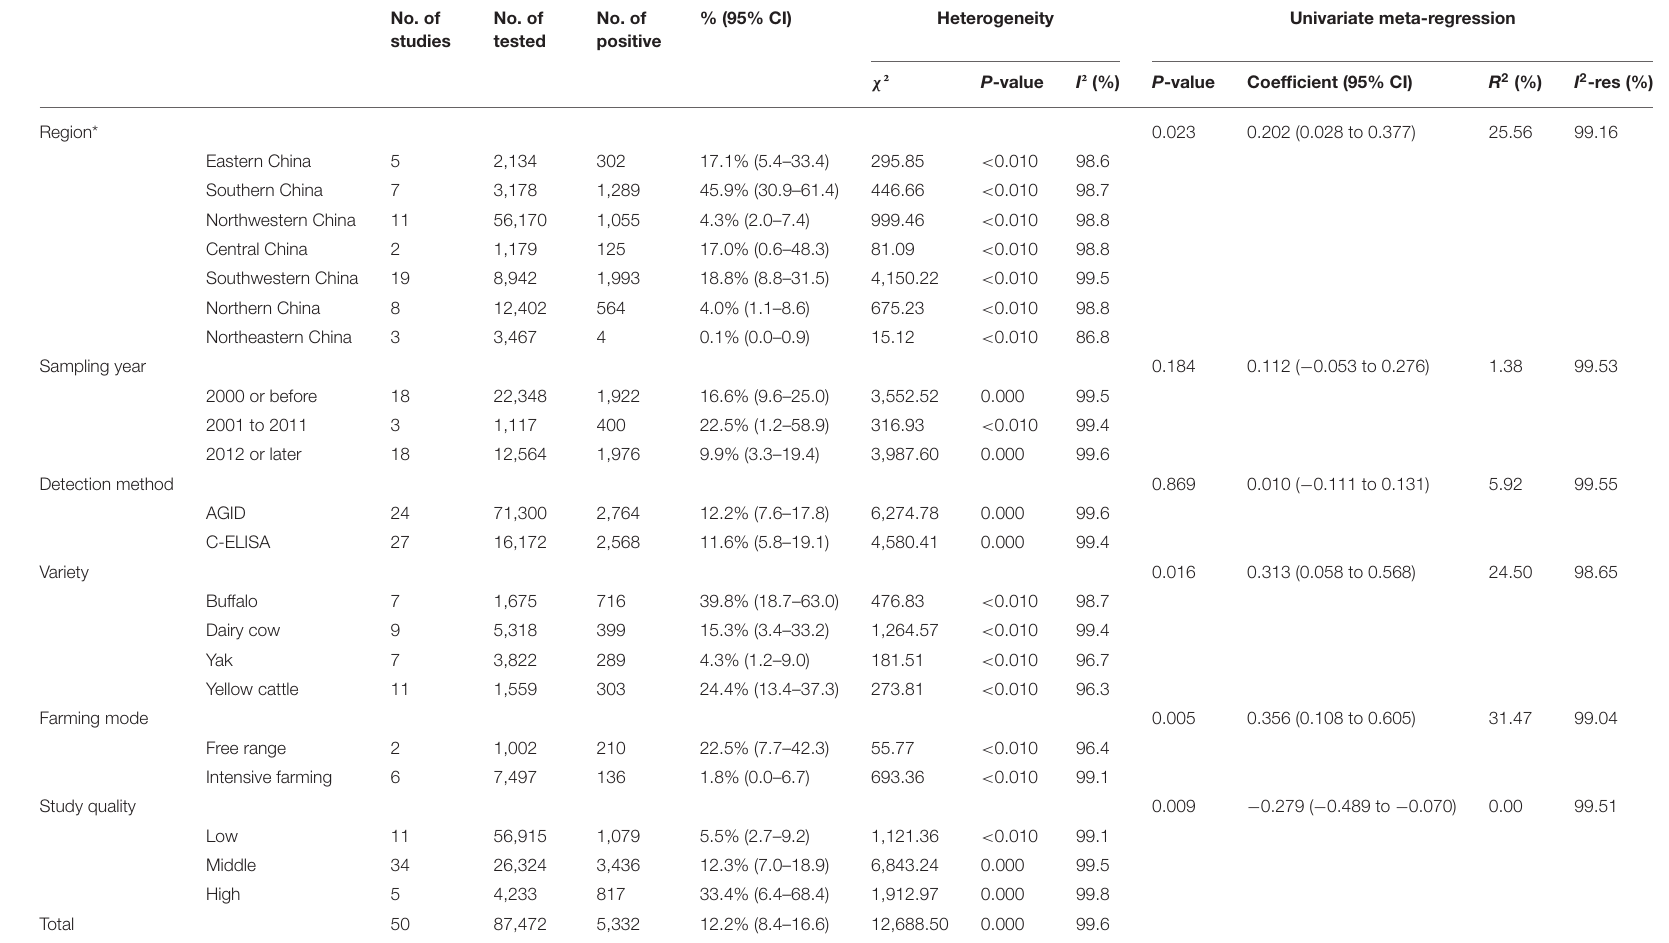
TABLE 3 | Pooled prevalence of bluetongue virus in cattle.